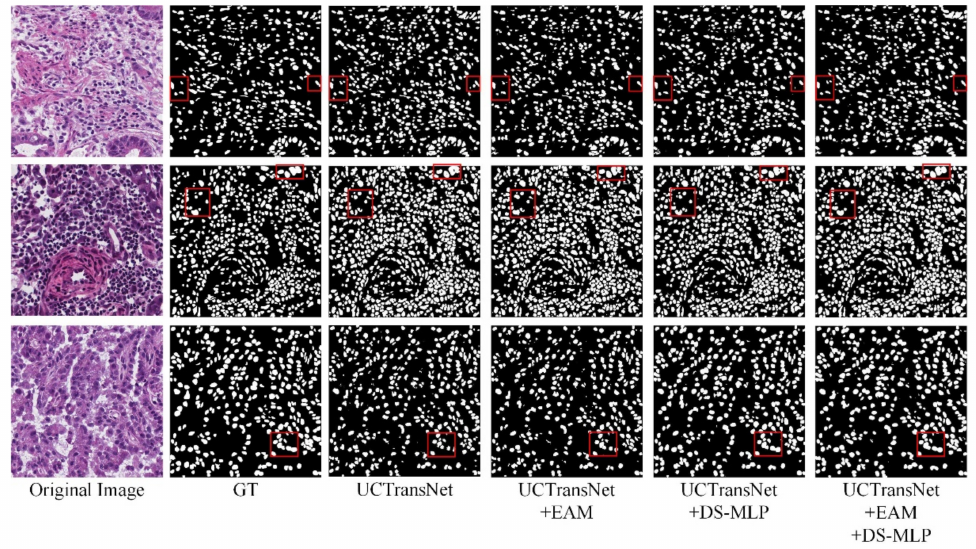
Figure 10. Visual comparison of each module in MoNuSeg dataset. In the red box are the parts with significant differences in the segmentation results of each network.